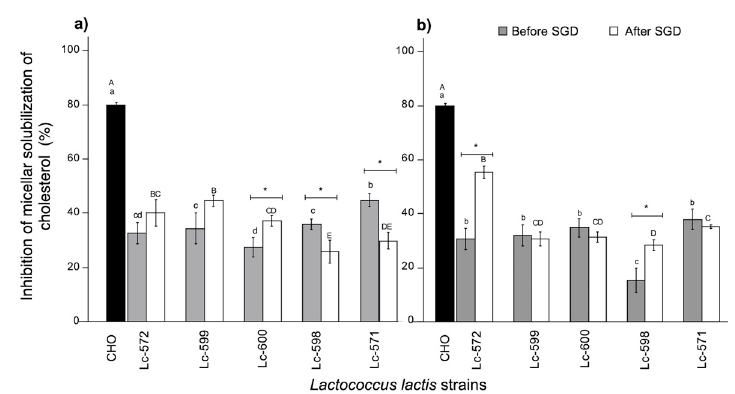
Figure 4. Inhibition of micellar solubility of cholesterol (%) by WSF from fermented milk with 24 ( a ) and 48 h ( b ) before and after simulated gastrointestinal digestion (SGD). Different letters represent significant differences ( p < 0.05) among strains before (lowercase, a – d) and after (uppercase, A – E) of SGD for the same time. Asterisk (*) represents significant differences ( p < 0.05) before and after SGD. Data are average (± SD) of triplicate samples. CHO: Cholestyramine.